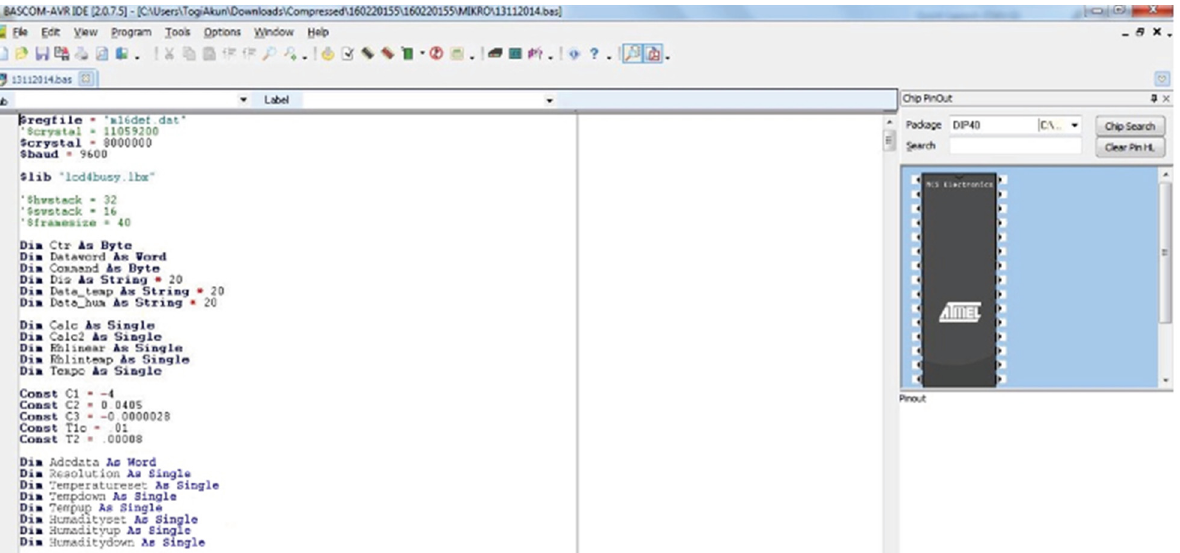
Figure 2. BASCOM AVR Program Form.